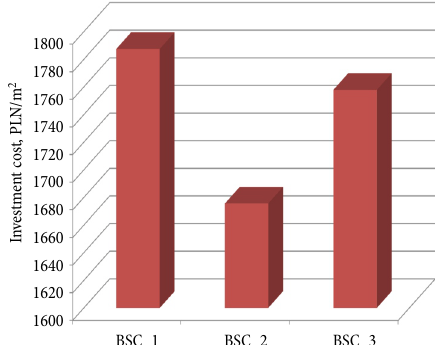
Fig. 1. The building unit costs for the analysed costs IC_4, PLN/m